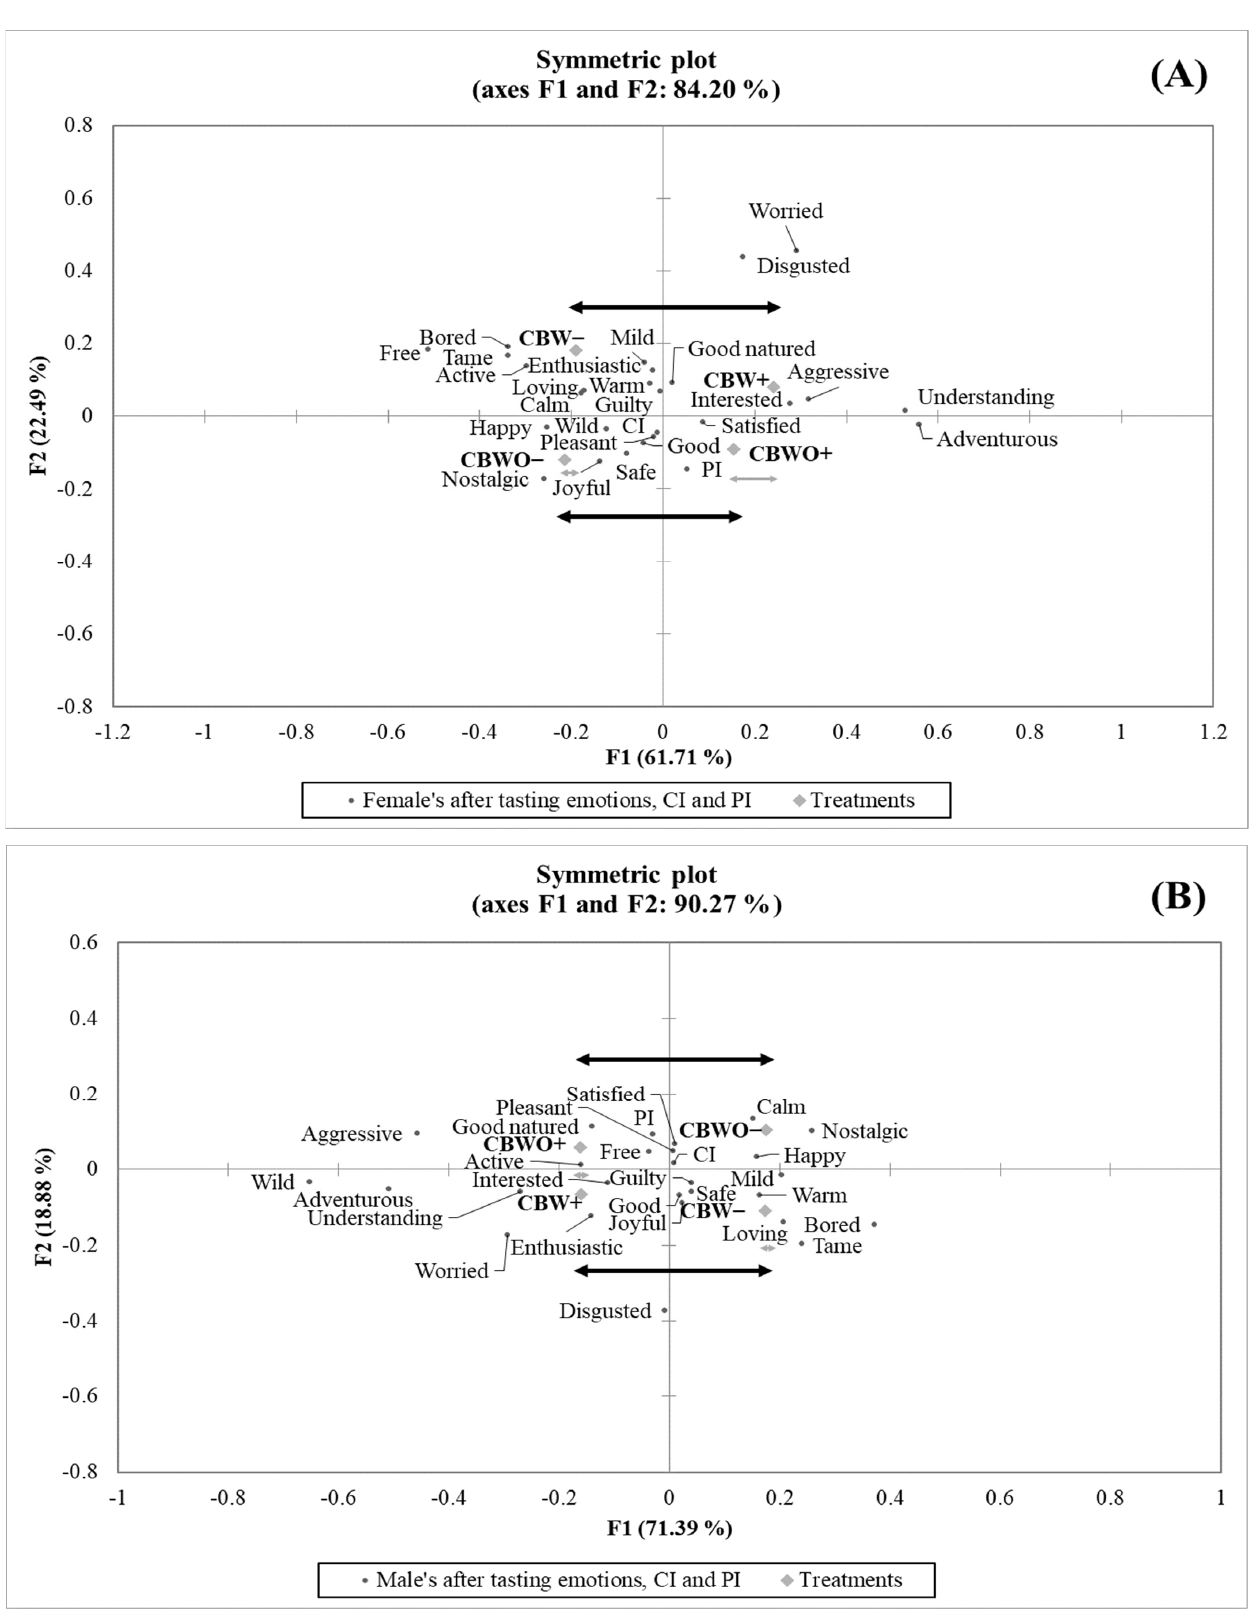
Figure 4. Correspondence analysis (chi-squared distance) symmetric plot visualizing emotions in the after-tasting condition, consumption intent (CI), purchase intent (PI), and treatments † from ( A ) female ( n = 112) and ( B ) male ( n = 98) groups. † Treatments are described in Figure 1.